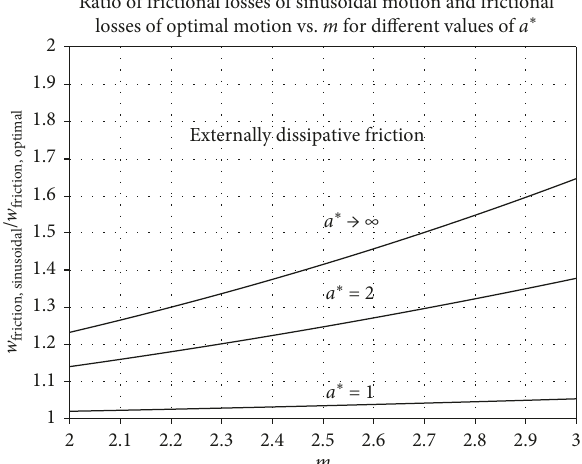
Figure 6: Ratio of work dissipated as friction with conventional piston motion relative to optimal piston motion, plotted against frictional exponent m (equation (2)), for three values of maximum piston acceleration: unbounded acceleration, a ∗ � 2, and a ∗ � 1. Maximum piston acceleration is expressed relative to its maximum value for conventional sinusoidal